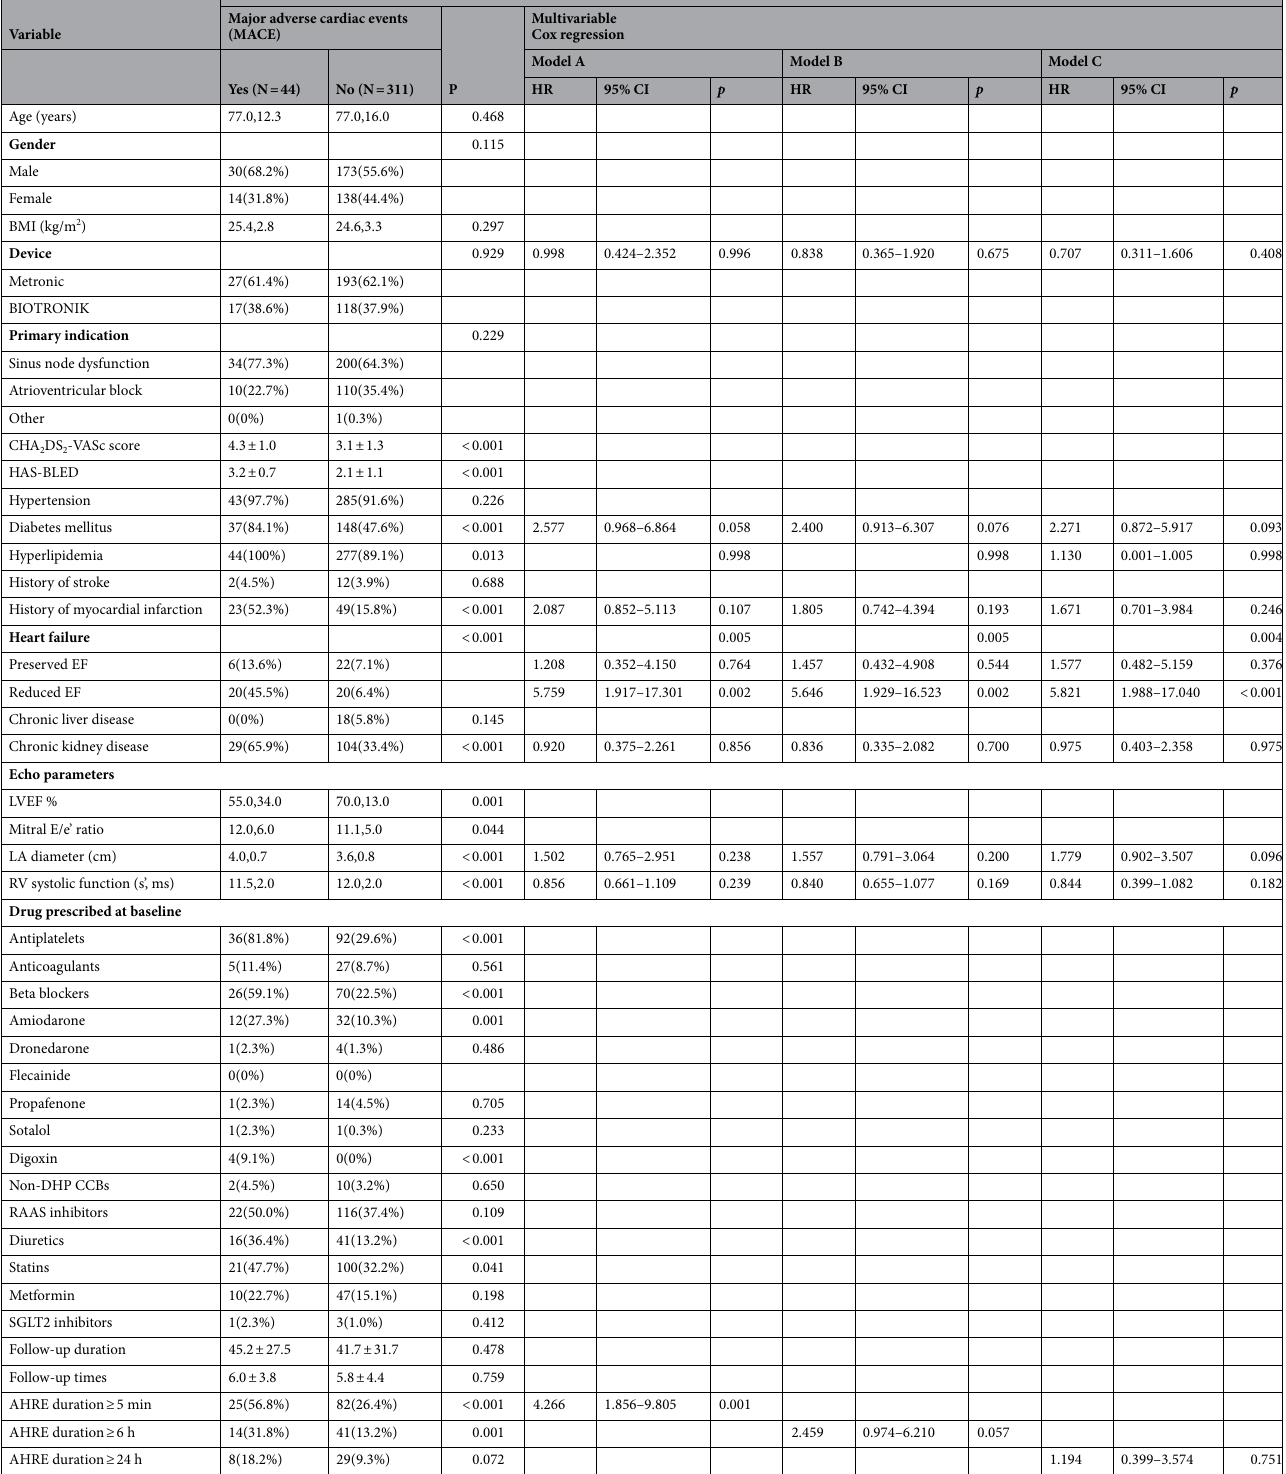
Table 4. Cox proportional hazard regression analysis with time-dependent covariates for MACE predictors in patients without history of atrial fibrillation and with AHREs ≥ 5mins (Model A), ≥ 6hrs (Model B), ≥ 24hrs (Model C). Data are presented as mean ± SD or median, IQR or n (%). AF atrial fibrillation, AHRE atrial high-rate episodes, BMI body mass index, EF ejection fraction, IQR interquartile range, LA left atrium, LVEF left ventricular ejection fraction, RV right ventricle, non-DHP CCBs non-dihydropyridine calcium channel blockers, RAAS renin–angiotensin–aldosterone system, SGLT2 sodium glucose co-transporters